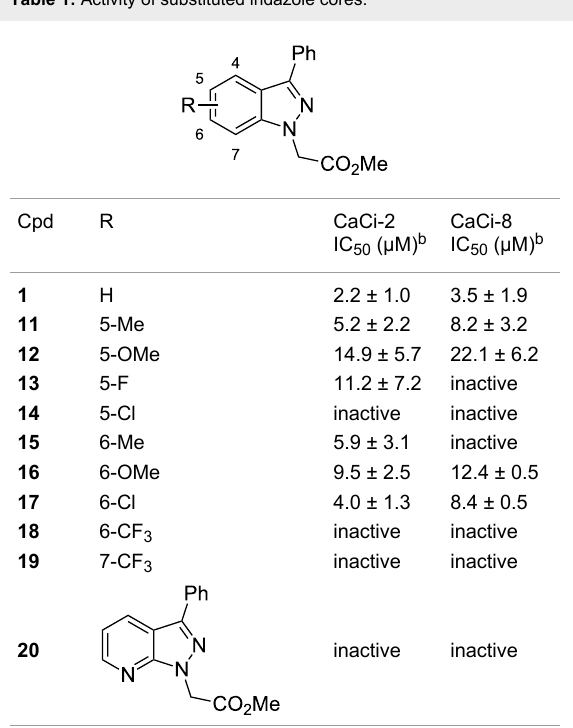
Table 1: Activity of substituted indazole cores.